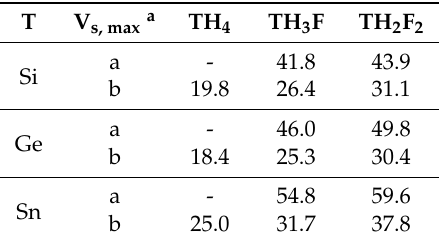
Table 1. Values of two maxima in the MEPs (V s,max , kcal/mol) of tetravalent σ -hole donors at the MP2/aug-cc-pVDZ-PP level of theory.